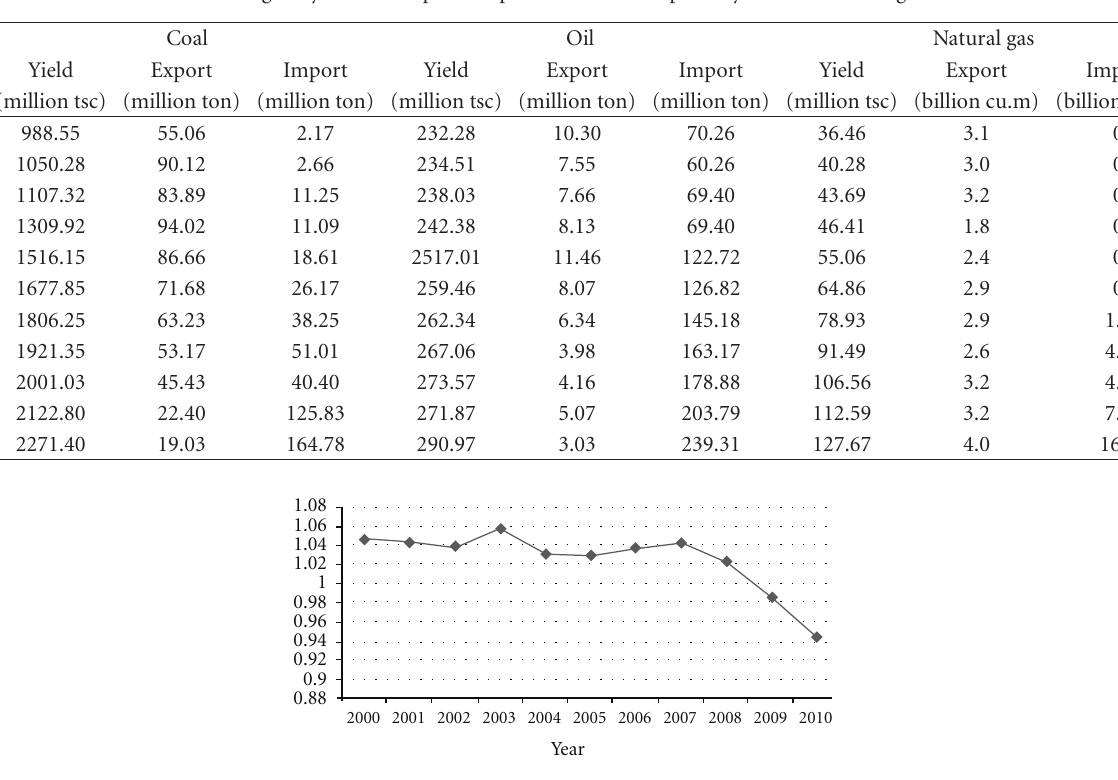
Table 2: The original yield and import/outport flows of three primary fossil fuels during 2000–2010.